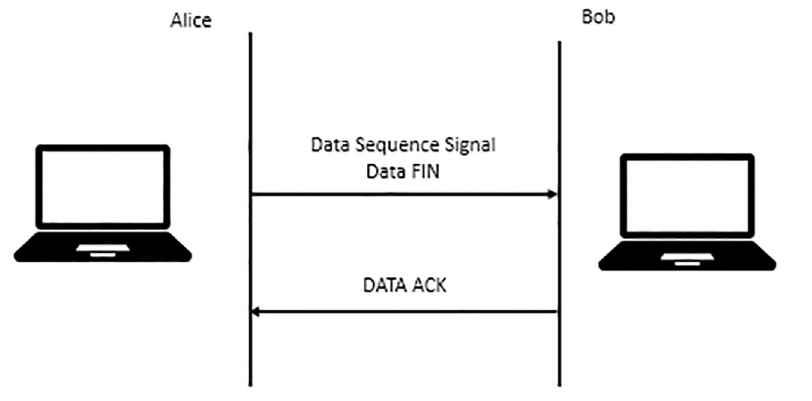
Fig 8. The closing of the MPTCP